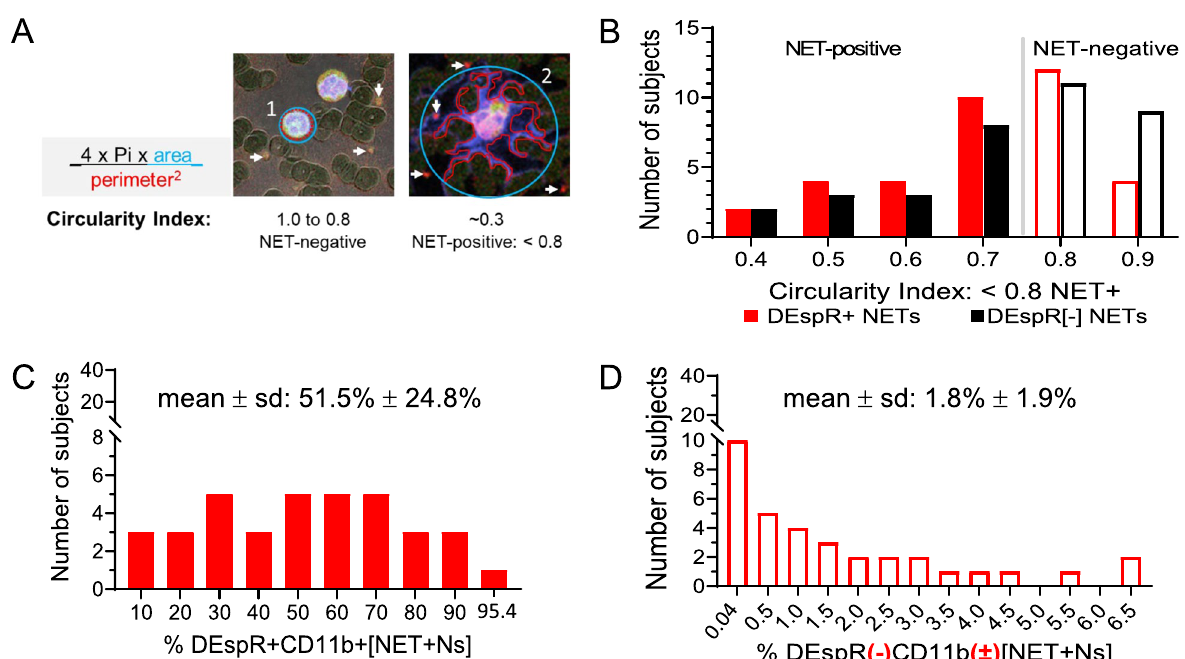
Fig. 2 Comparative quantitative analysis of circulating NET Ns using automated shape analysis in COVID‑19 peripheral blood smears. A Diagram + of circularity index determination and B corresponding frequency graph of the spread of circularity indices calculated by automated shape‑analysis algorithm with designation of < 0.8 as cut‑off for assignment of NET‑forming neutrophils or [NET subjects (n 36) with DEspR CD11b [NET Ns]: median 53.4% (IQR: 28.2 – 68.5%), mean = + + + COVID‑19 subjects ( n 36) with DEspR(‑)CD11b( ) [NET Ns]: median 1.0% (IQR: 0.2 – 3.1%); mean = ± +